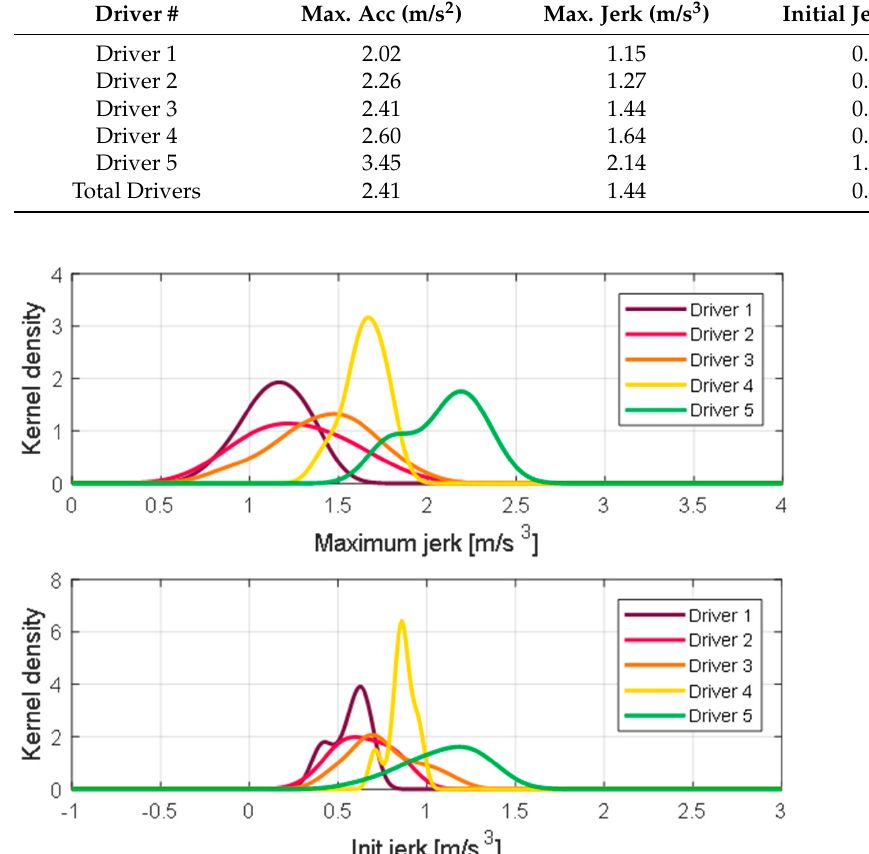
Figure 8. KDE of maximum jerk and initial jerk during the initial acceleration section.